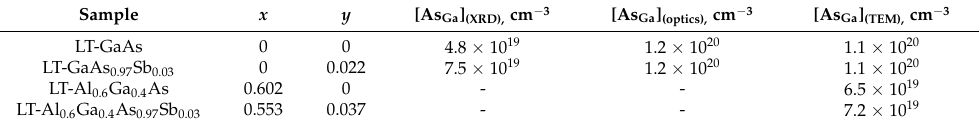
Table 2. Chemical composition of the samples and concentration of the antisite defects.